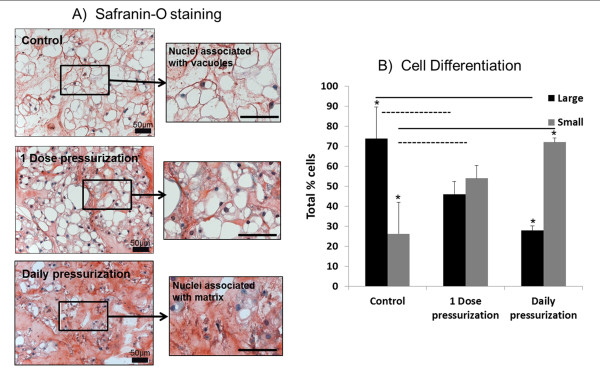
Safranin O/Fast green staining of Control, 1 Dose and Daily pressurized nucleus pulposus tissue. (A) Nucleus pulposus (NP) tissue demonstrated increased accumulation of proteoglycan (red staining) with pressurization and this was greatest with the Daily pressurization group. (B) A notable change in cell morphology was also observed with loading, with fewer large notochordal cells (NCs) and increased numbers of small nucleus pulposus cell (SNPCs) with load compared with the Control group (black bars). The 1 Dose pressurization group also demonstrated significant differences from the Control group (grey bars) and there were significant differences between NCs and SNPCs in the Control and Daily pressurization groups (*). To quantify this, the number of large NCs versus SNPCs was calculated based on the criteria shown in Figure 2 (P < 0.0002).